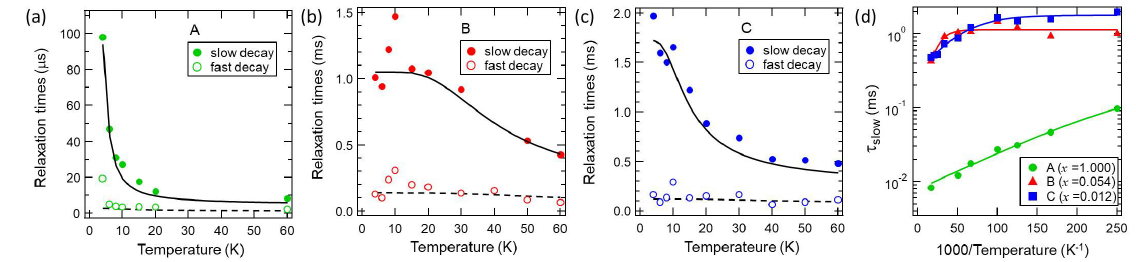
Figure 6. Temperature dependences of the relaxation times, τ fast (open circles) and τ slow (solid circles), for the three samples; ( a ) A: x = 1.000, ( b ) B: x = 0.054, and ( c ) C: x = 0.012. The solid and dashed lines are results of model calculation. ( d ) Arrhenius plot of τ slow in Sample A (circles), B (triangles), and C (squares). The solid lines are the fittings by using Equation